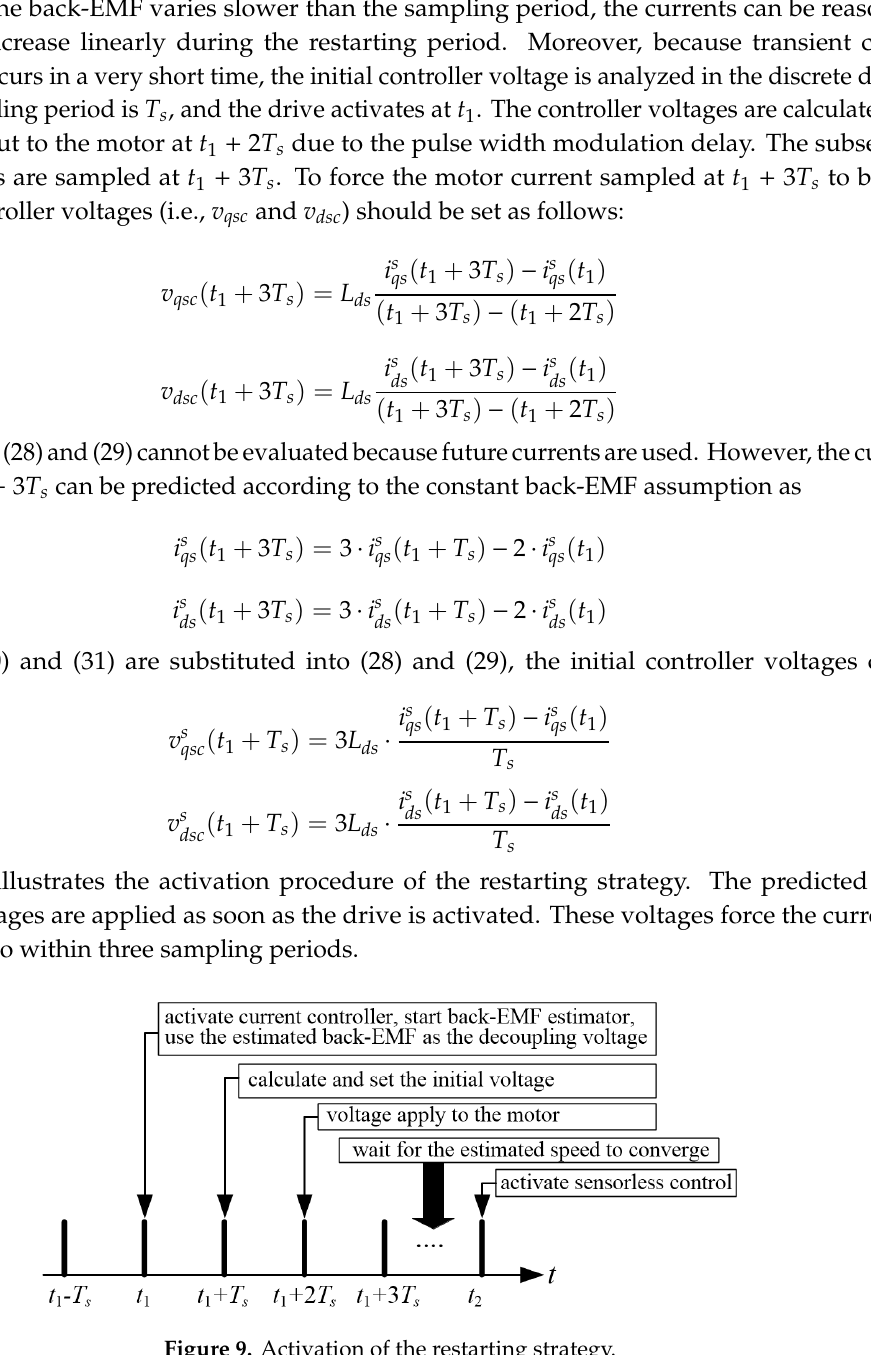
Figure 9. Activation of the restarting strategy.